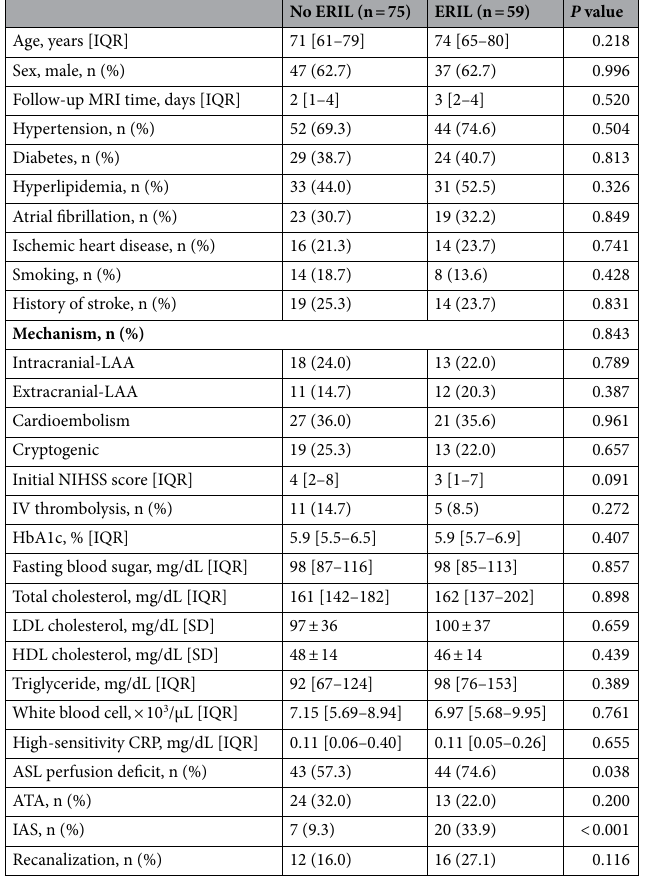
Table 1. Baseline characteristics of patients with and without ERILs. ERIL early recurrent ischemic lesion, MRI magnetic resonance imaging, LAA large artery atherosclerosis, NIHSS National Institutes of Health Stroke Scale, IV intravenous, HbA1c hemoglobin A1c, LDL low-density lipoprotein, HDL high-density lipoprotein, CRP c-reactive protein, ASL arterial spin labeling, ATA arterial transit artifact, IAS intraarterial high-intensity